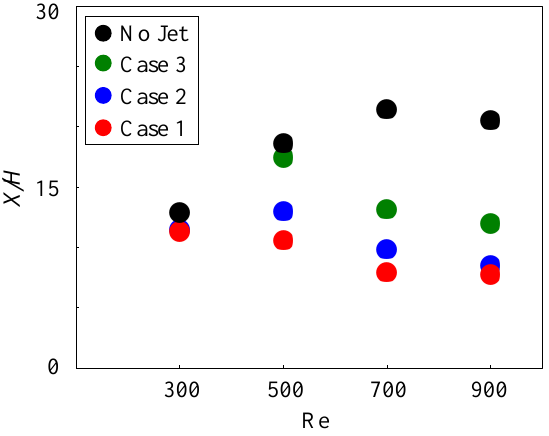
Fig. 11 Spanwise-averaged reattachment points at case 1-3.